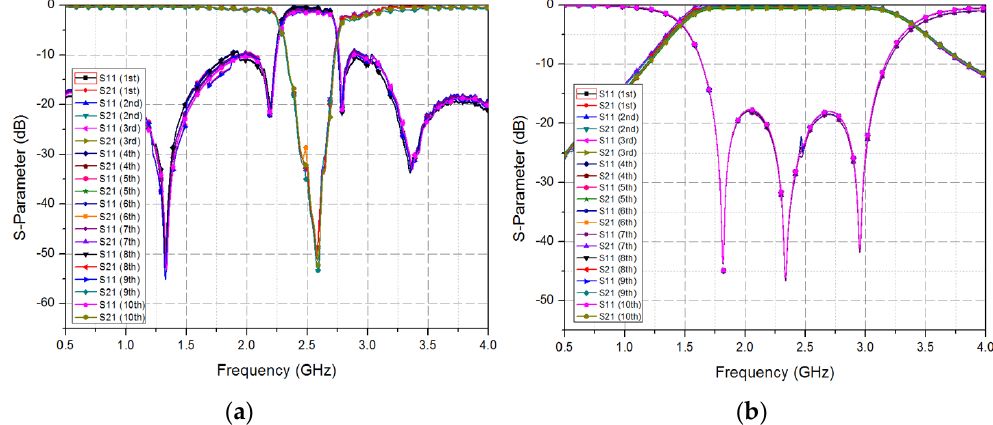
Figure 7. Measured S-parameter results of the fabricated filter after 10 times switching: ( a ) BSF and ( b ) BPF.